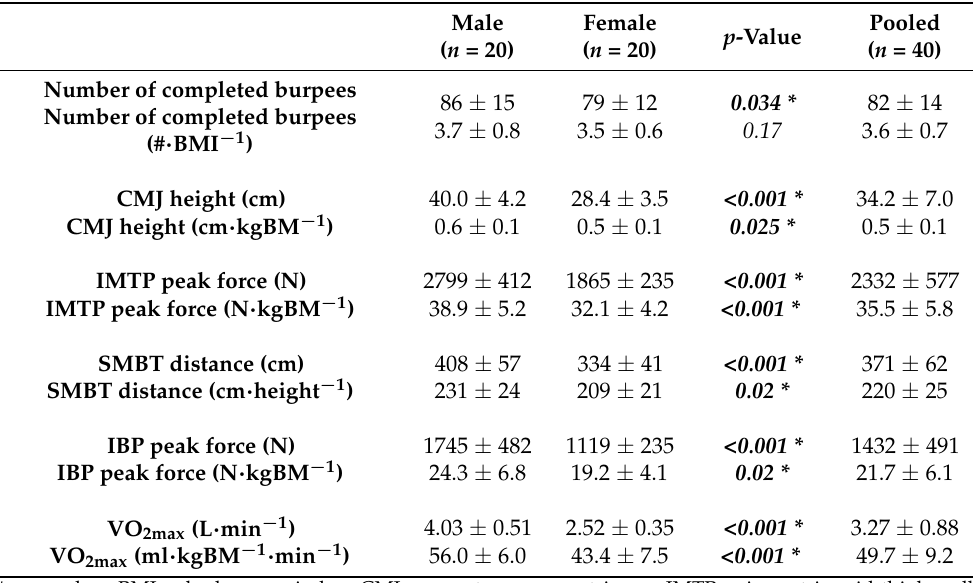
Table 4. Part II (validity). Descriptive statistics of the number of burpees completed in the 3-min burpee test (3-MBT) and physical fitness assessments in absolute and relative (to body mass (BM) or to height) in male and female athletes.